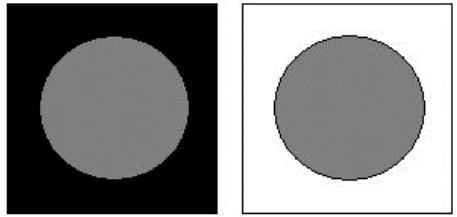
Fig. 1. The impact of sight adaptation on the percep- tion of brightness. Gray figure on a black background appears brighter than the same figure placed against a white